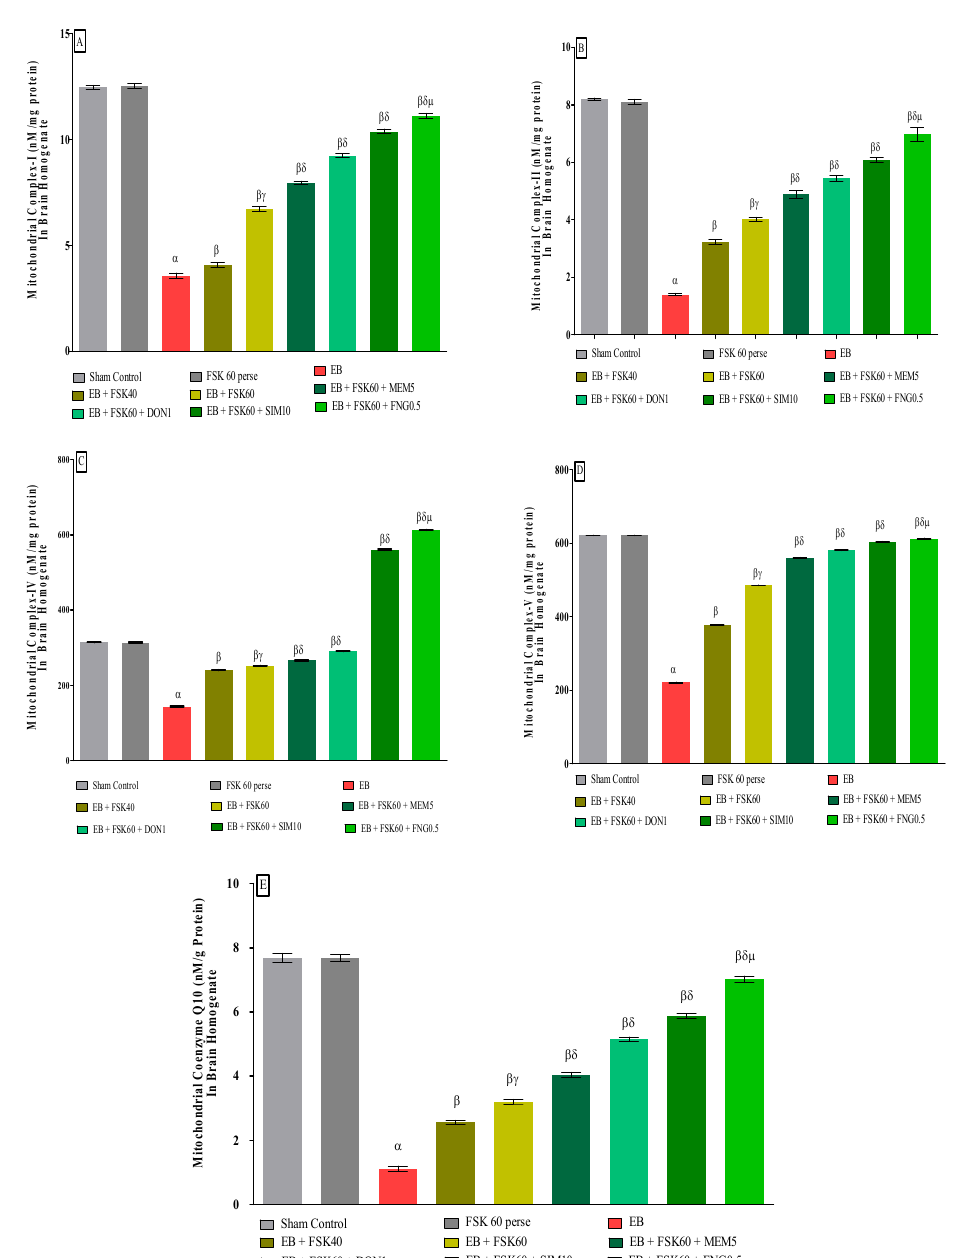
Figure 8. ( A – E ): Protective role of FSK in restoring mitochondrial ETC complex enzymes in experimental multiple sclerosis rats. Analysis of Variance (ANOVA) with Tukey’s test was used to evaluate the data, which were presented as mean with SD ( n = 6). α EB (p < 0.01) v / s Sham control and FSK40 perse; β EB + FSK40, EB + FSK60, EB + FSK60 + MEM5, EB + FSK60 + DON1, EB + FSK60 + SIM10, EB + FSK60 + FNG0.5 (p < 0.01) v / s EB; βγ EB + FSK60 (p < 0.01) v / s EB + FSK40; βδ EB + FSK60 + MEM5, EB + FSK60 + DON, EB + FSK60 + SIM10, EB + FSK60 + FNG0.5 (p < 0.01) v / s EB + FSK40, EB + FSK60; βδμ EB + FSK60 + FNG0.5 (p < 0.01) v / s, EB + FSK60 + SIM10, EB + FSK60 + DON1, EB + FSK60 + MEM5.